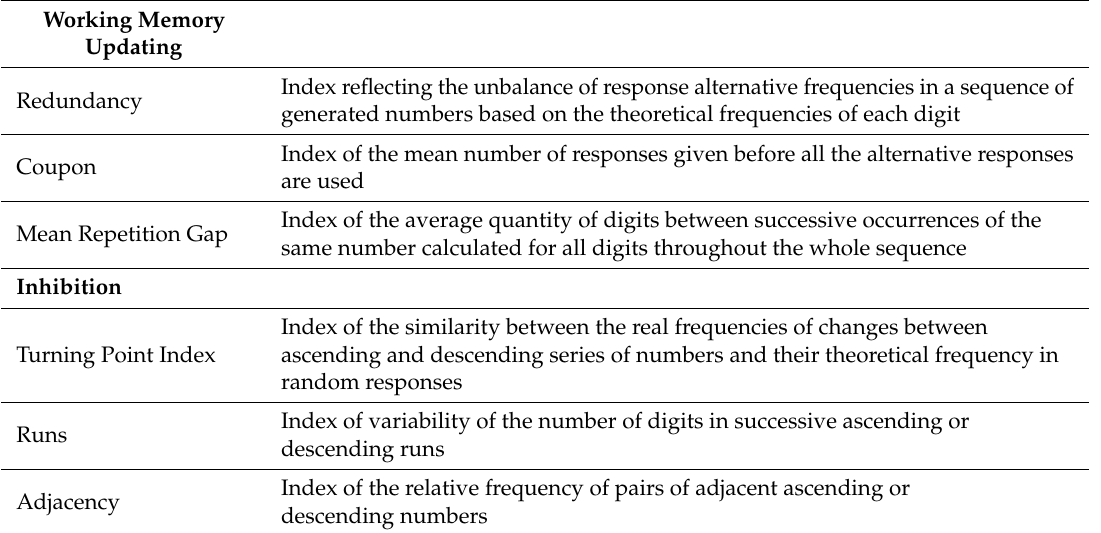
Table 3. Description of the executive function indices obtained from the random number generation